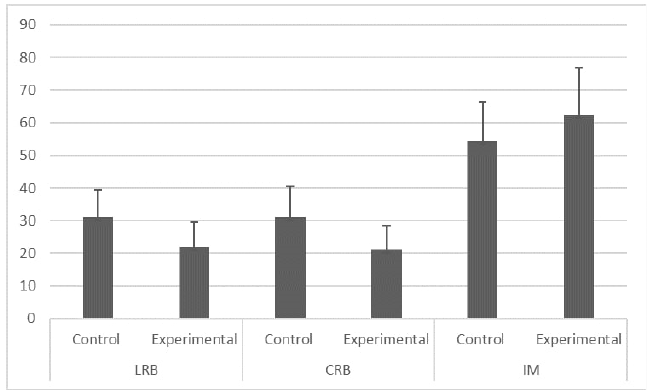
Figure 3. Mean and standard